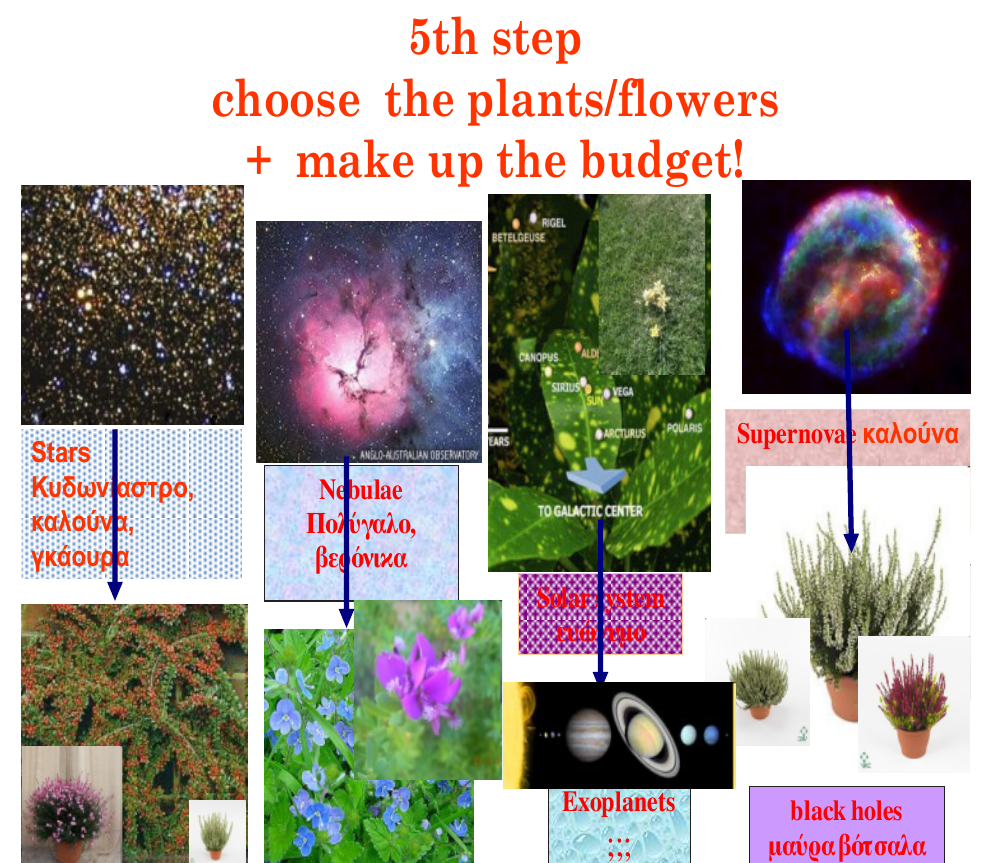
Fig.2 The Galactic Garden. Fig.4 The correspondence between flowers and astronomical